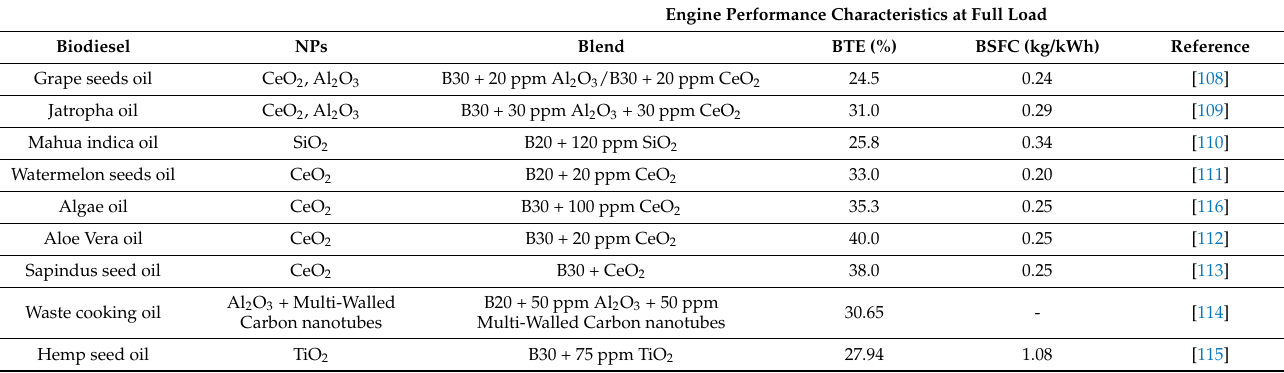
Table 4. The effects of different nanoparticles on engine performance